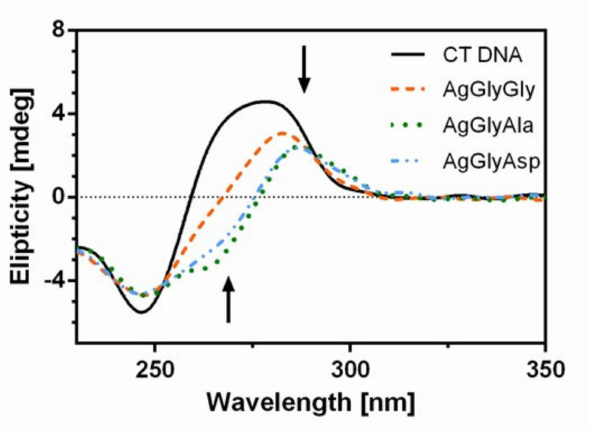
Figure 12. CD spectra of CT DNA in 10 mM Tris buffer in the presence of silver(I) dipeptide